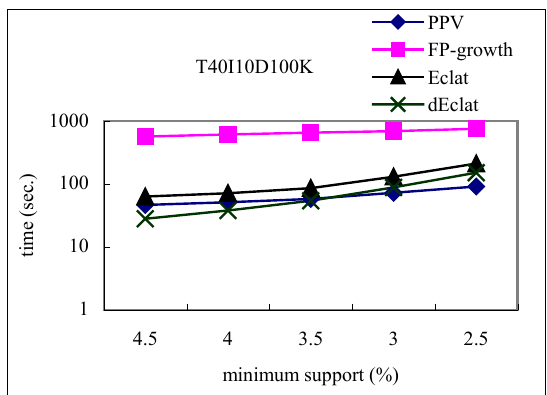
Fig. 5. Comparative Performance on